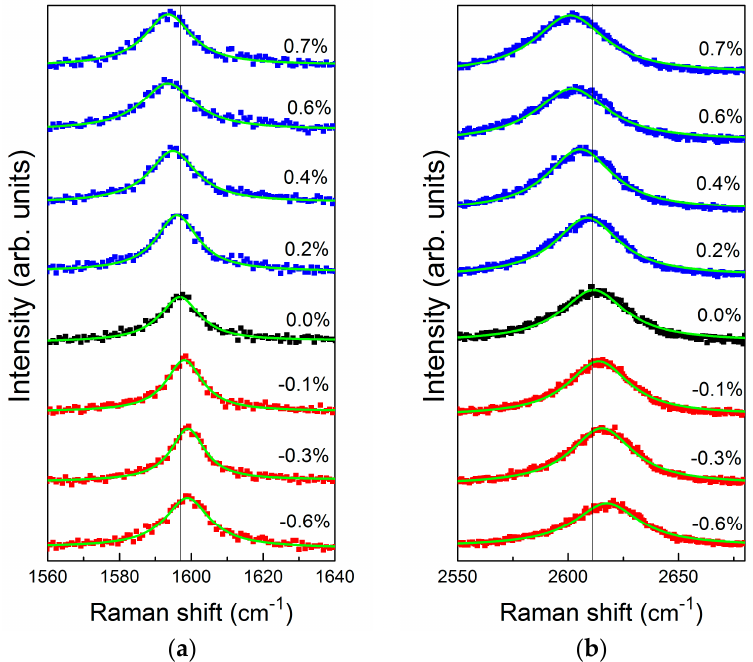
Figure 5. Evolution of the G ( a ) and 2D ( b ) bands as a function of the strain, for the embedded CVD graphene micro-ribbons. The original measurements are plotted as points (blue for tension and red for compression). Solid lines represent Lorentzian fits to the experimental data.